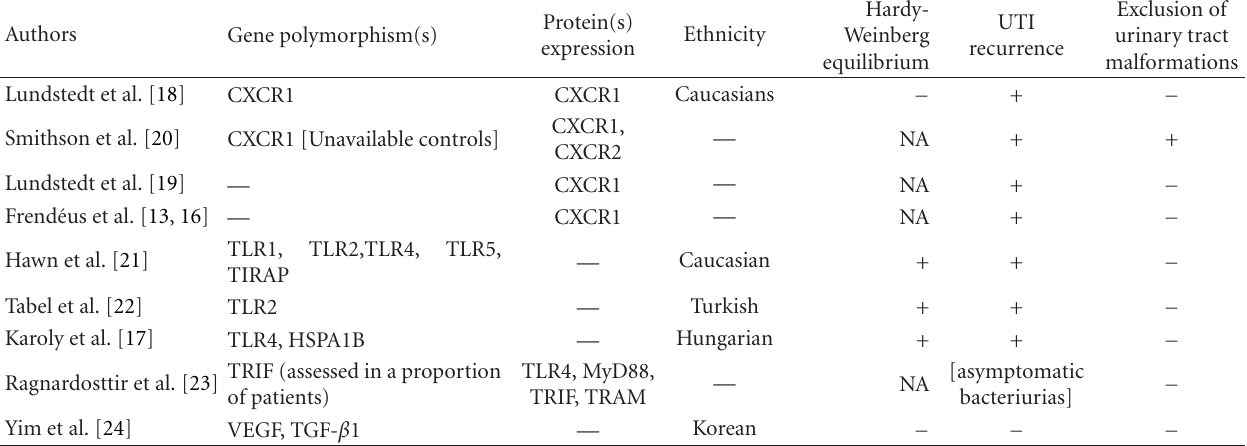
Table 4: Methodological quality of each included study. The studies are listed according to their presentation along this review. (CXCR: IL-8 receptor; MyD88: myeloid di ff erentiation primary response gene 88; NA: not applicable; SIGIRR: single immunoglobulin domain- containing IL-1 receptor-related molecule; TLR: Toll-like receptor; TRAM: TIR domain–containing adaptor inducing IFN- β –related adaptor molecule; TRIF: TIR domain-containing adaptor inducing INF- β